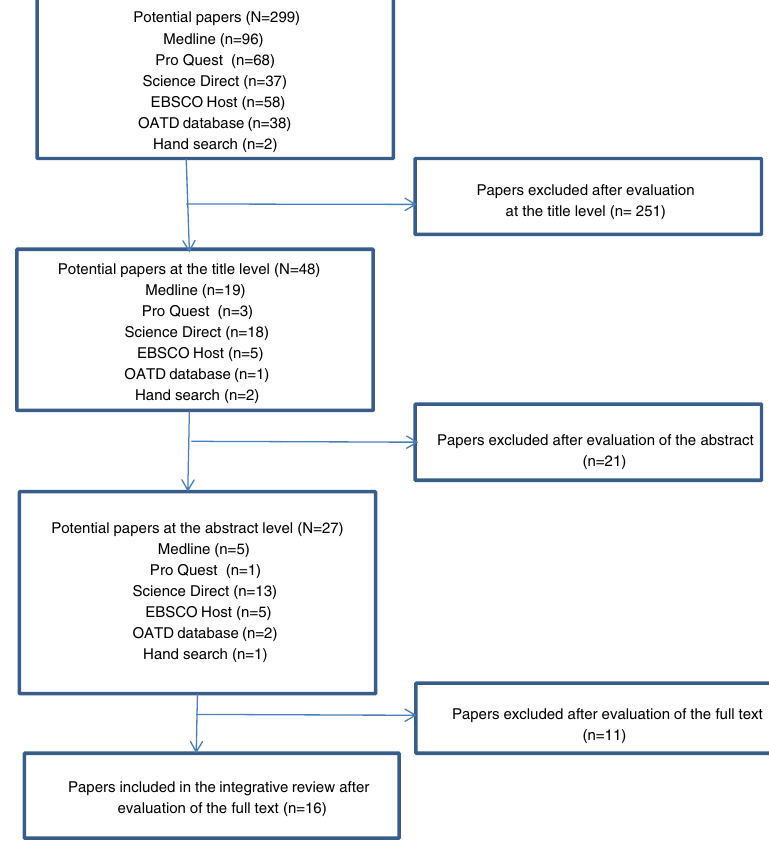
Fig. 1 The selection process of the